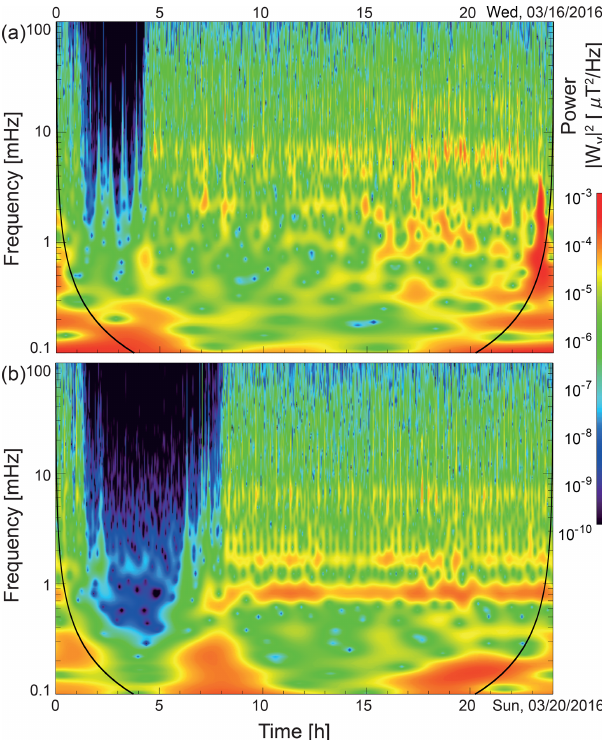
Figure 8. BART night signatures. Continuous wavelet transform of magnetic field magnitude data at one sample per second from station 2 on Wednesday, 16 March 2016 (a) and Sunday, 20 March 2016 (b) . The nighttime signature is significantly shorter in the data taken on Wednesday; this corresponds to BART operat- ing hours. Additionally, the strong power bands observed on Sunday are not present in the Wednesday